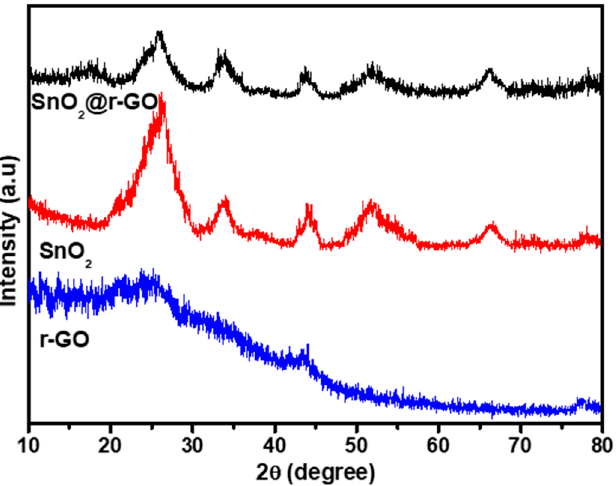
Figure 1. XRD analysis of rGO, SnO 2 nanoparticles, and SnO 2 @rGO nanocomposite.